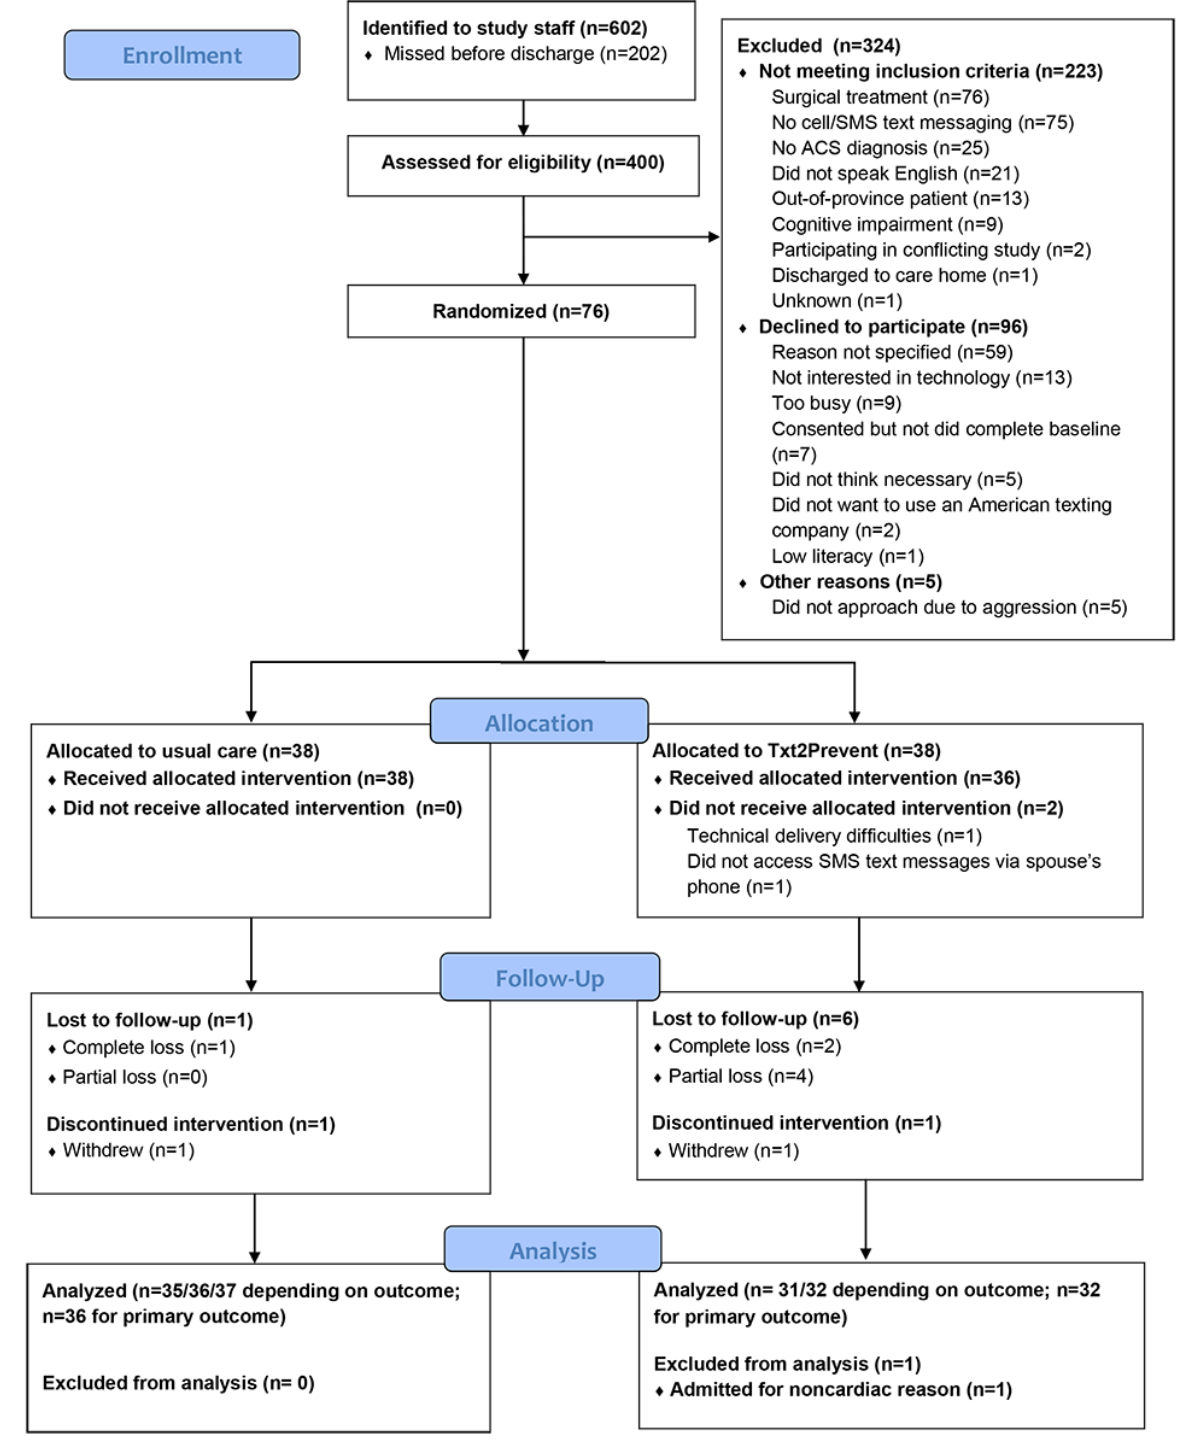
Figure 1. CONSORT flow